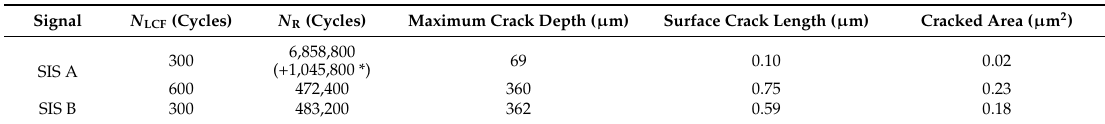
Table 4. Quantitative damage measurements from interrupted tests with SIS A and SIS B signals in the PWR